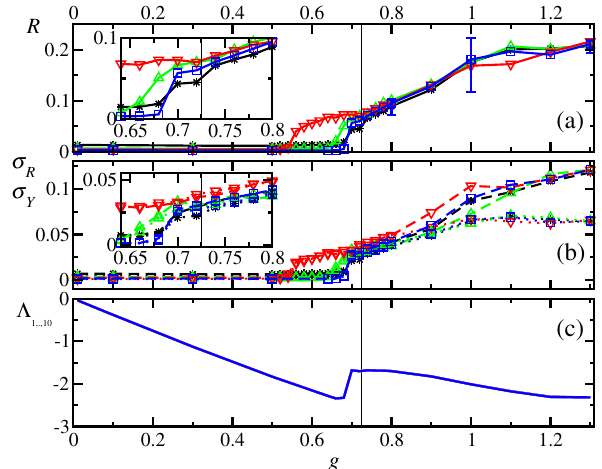
FIG. 4. Phase diagram: Dependence of the Kuramoto order parameter R (a), its standard deviation σ , the standard deviation R σ of the activity field Y (b), and the ten largest Lyapunov Y exponents (c) versus the coupling strength g . The curves in (a) and (b) have been obtained for N ¼ 4000 (black), N ¼ 16000 (green), and N ¼ 64000 (blue), upon increasing the coupling g . The red curve (a and b) is a continuation by decreasing g with N ¼ 64000 , and σ and σ are represented with dashed and R Y dotted lines, respectively (b). The vertical lines mark the critical ≈ 0 . 72 , where the linear stability of the asynchronous point g c state is lost (see Sec. III). The insets in panels (a) and (b) reveal the zone of the fuzzy transition. The ten largest global Lyapunov exponents in panel (c) are almost indistinguishable. The simu- lations have been performed for N ¼ 64000 , increasing g . We introduce and discuss the global Lyapunov exponent in the last paragraph of this